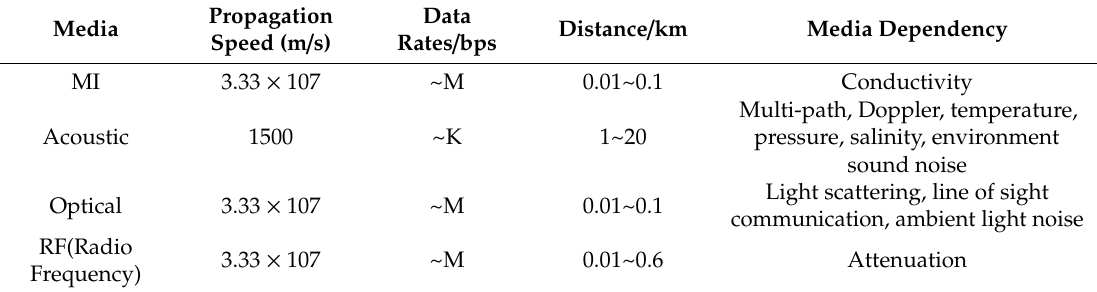
Table 1. Characteristics of underwater MI (magnetic induction), acoustic, and optical